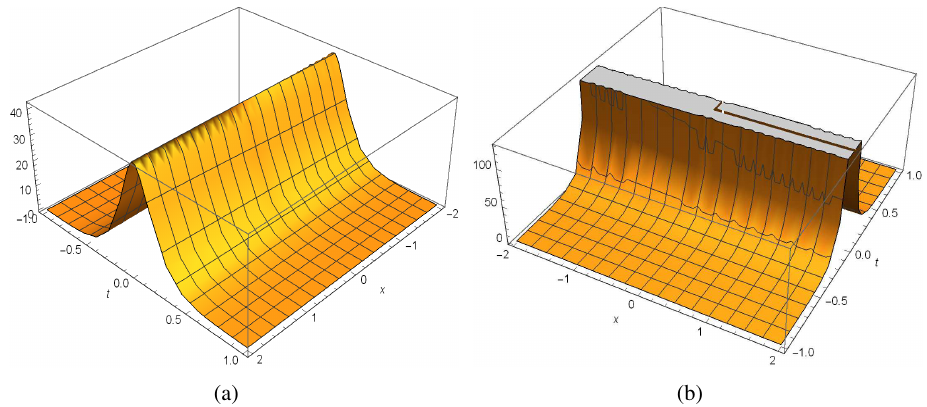
Fig. 2 The 3D surfaces of (a) Eq. (4.9) and (b) Eq. (4.10) with fractional value α = 0 .